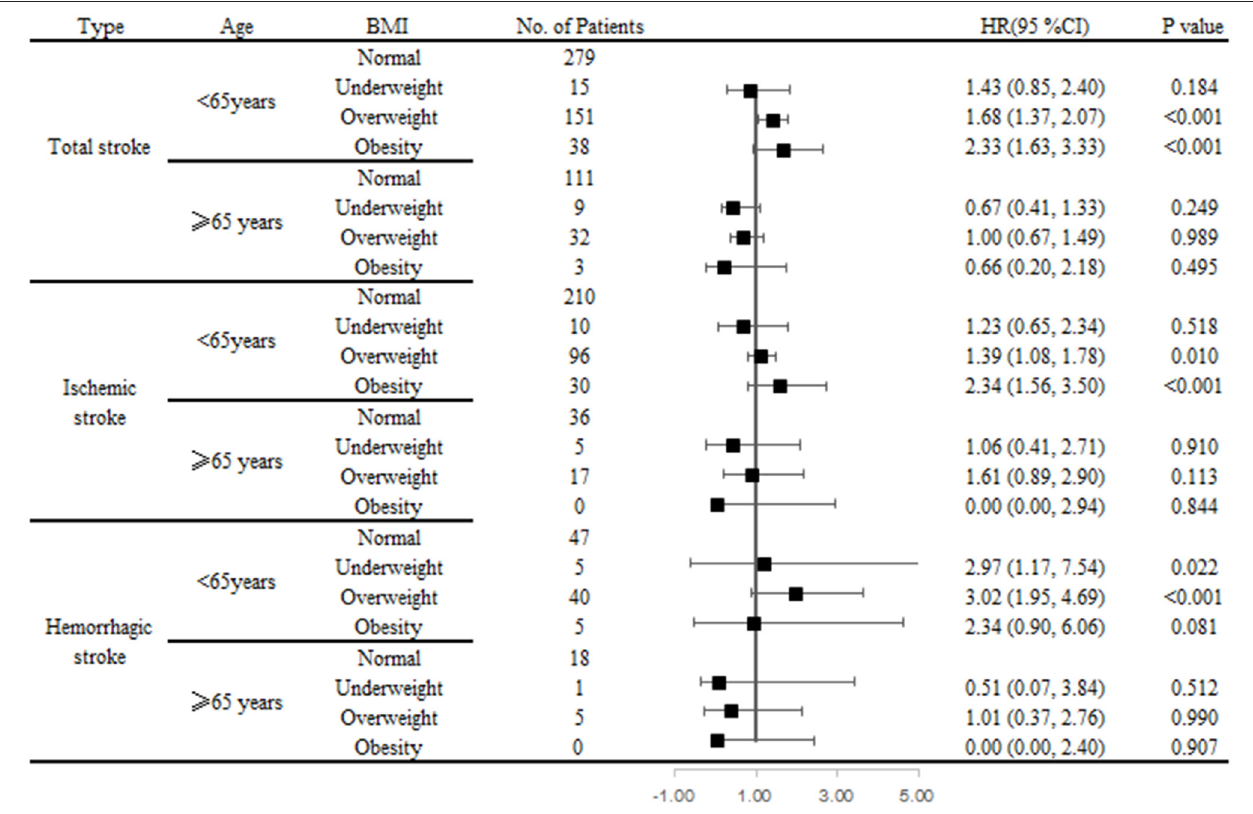
FIGURE 2 | Association of BMI and stroke risk by types and age groups using Cox regression